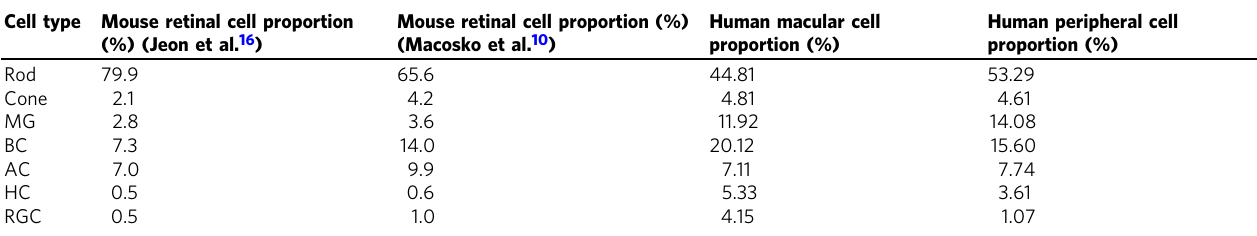
Table 3 Comparison of proportion of major cell types of mouse and human